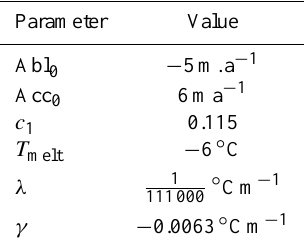
Table 1. List of parameter values involved in the parameterisation of the surface mass balance. As F clim is a time-evolving climatic pa- rameter, its value will be specified for each experiment in Sect.